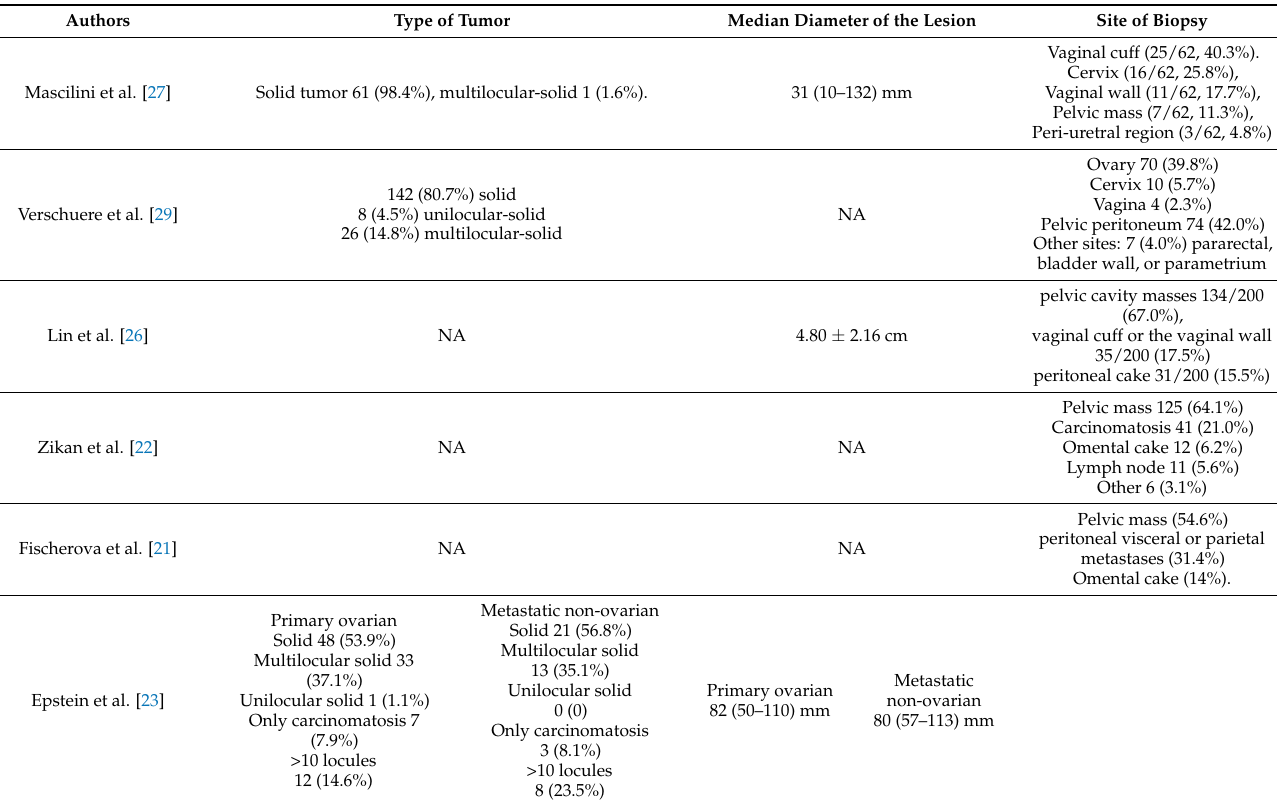
Table 4. Ultrasound characteristics of patients who underwent histological